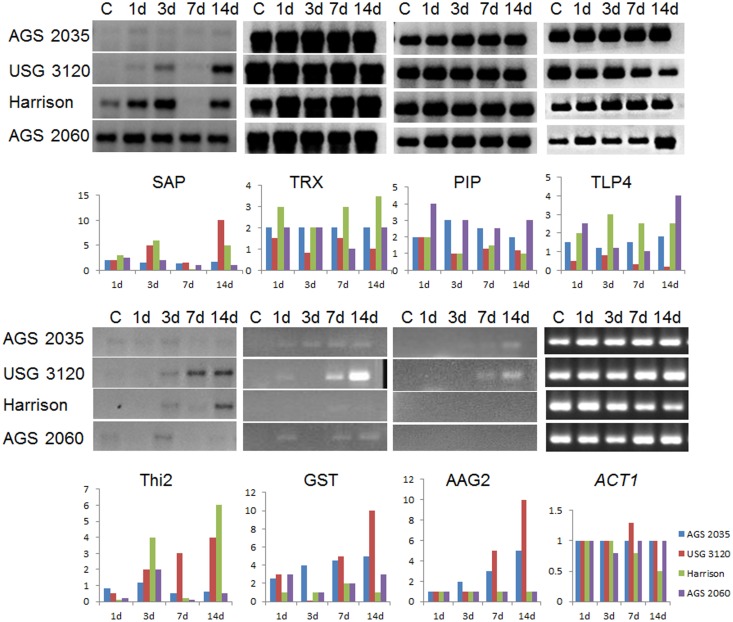
Semiquantitative RT-PCR showing temporal variation in expression of seven genes of wheat in response to metribuzin.SAP, senescence-associate protein; TRX, thioredoxin; PIP, plasmamembrane-intrinsic protein; TLP4, thaumatin-like protein 4; Thi2, thiamine biosynthesis gene 2; GST, galactinol-sucrose galactosyltransferase; AAG2, alkaline alpha glactosidase 2; ACT1, actin 1 (used as internal control). Bar graphs below each gene represent the densitometry-based unreplicated quantitation of the band intensity at different time points relative to control (C). d, day(s) after metribuzin application.